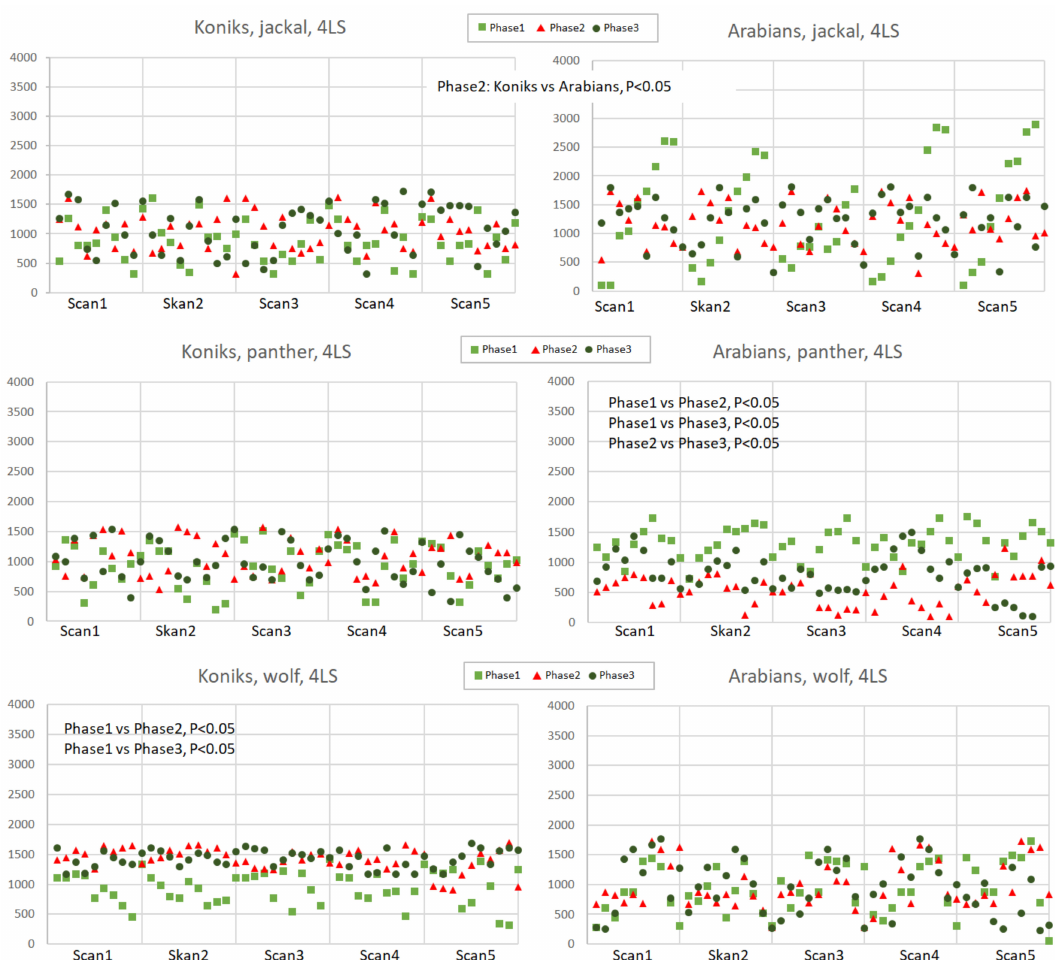
Figure A4. Distance to the nearest loudspeaker (DIST-LS, cm) in Koniks and Arabians in response to jackal’s, leopard’s and wolf’s vocalisation played from 4LS in pre-, playback and post-playback phases. Each point represents the distance of individual horse from the nearest LS. Phases are depicted with light green squares (phase 1, pre-playback), red triangles (phase 2, playback) and dark green circles (phase 3, post-playback). Only significant di ff erences between breeds and phases were shown in the